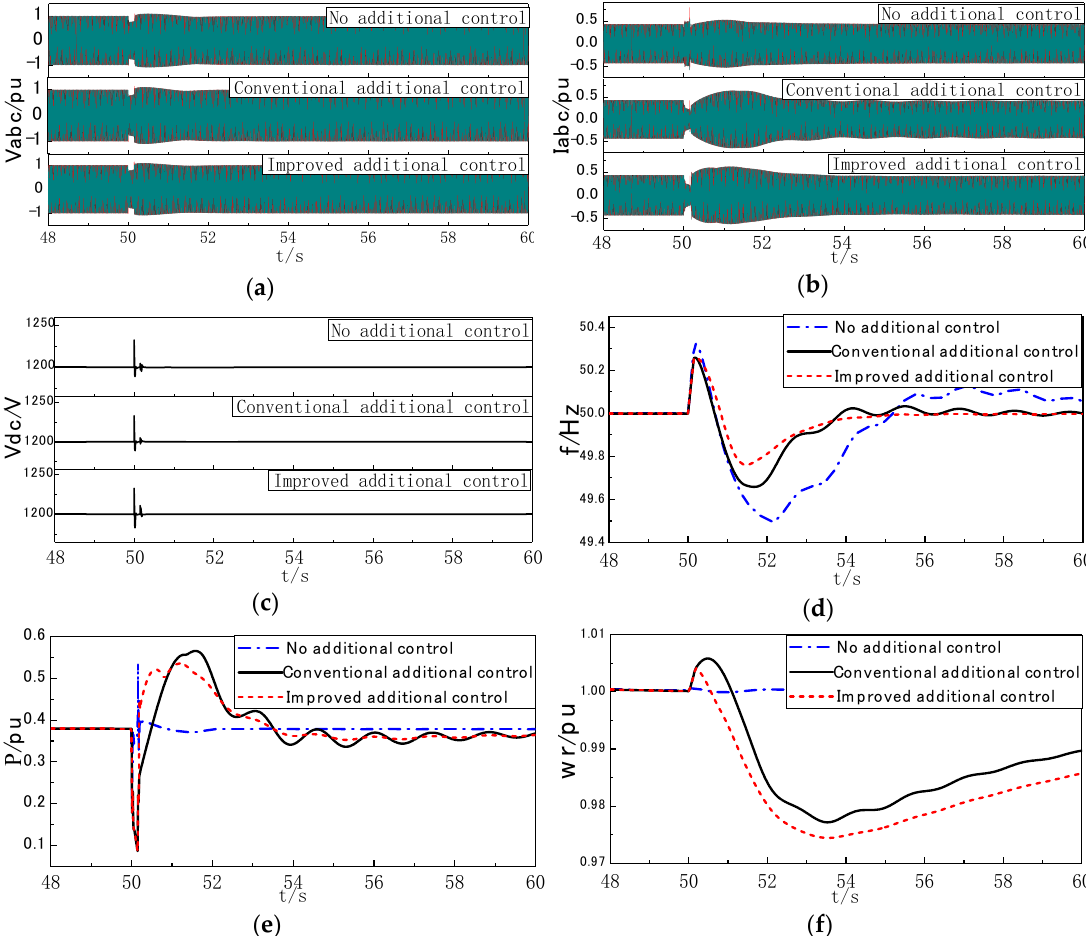
Figure 8. Variation of parameters under a short-circuit fault by three different control methods ( a ) Voltage of the DFIGs; ( b ) Current at the common connection point between the DFIGs and the grid; ( c ) DC voltage of converter; ( d ) System frequency; ( e ) Active power provided by DFIGs; ( f ) Rotor speed of DFIGs